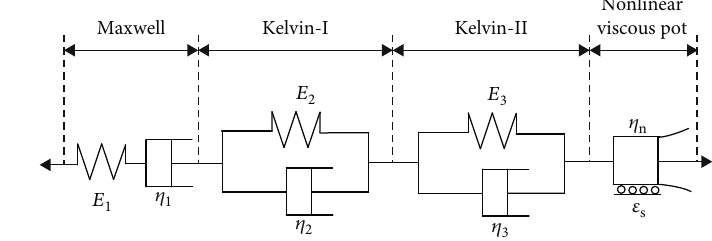
Figure 4: Improved generalized Burgers creep